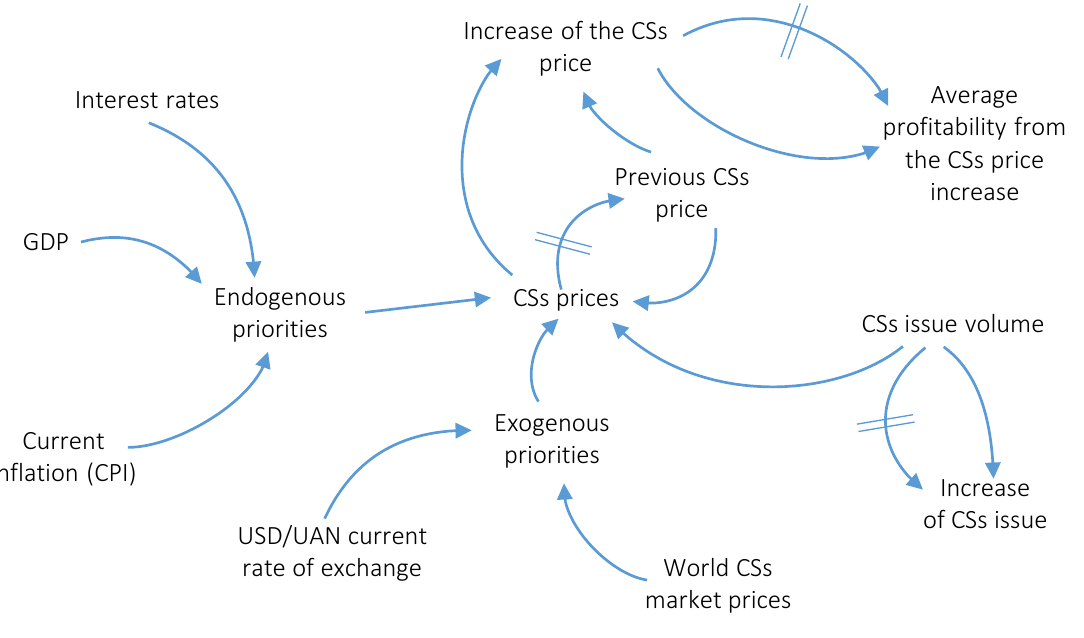
Figure 2. Causal relationships of the descriptive